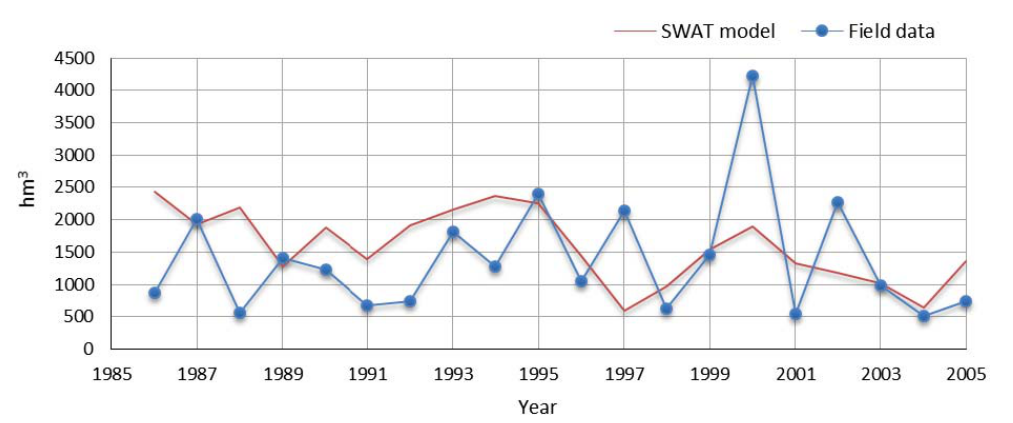
Figure 4. Annual flow according to SNIRH record values for Fridão hydrometric station, and estimated by SWAT model.